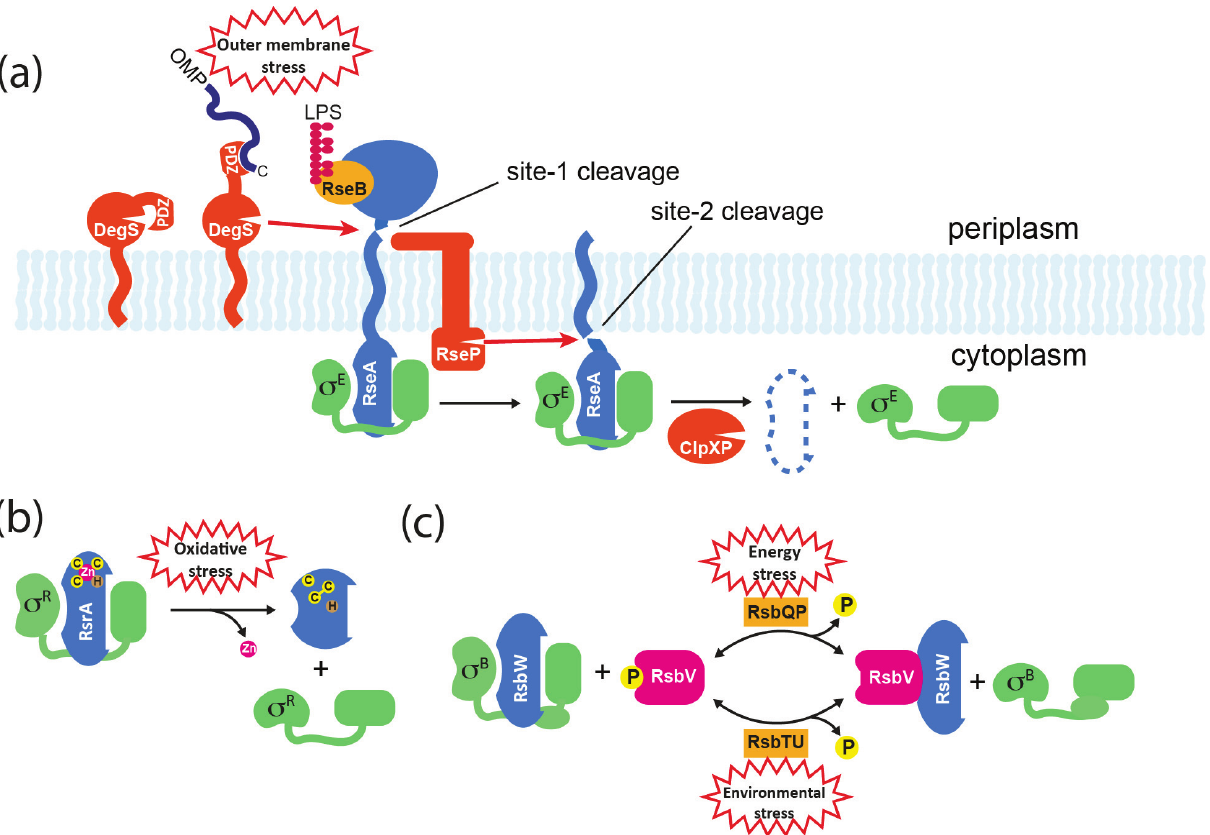
Figure 4. Mechanisms for (cid:2) factor release from anti-(cid:2) factors. ( a ) Activation of (cid:2) E in E. coli . The membrane-spanning anti-(cid:2) RseA binds (cid:2) E through its cytoplasmic ASD. The C-termini of OMPs that accumulate in the periplasm activate DegS protease through binding to its PDZ domain, resulting in site-1 cleavage of RseA. DegS–dependent cleavage of RseA is inhibited by RseB, and this can be relieved by the accumulation of lipopolysaccharide (LPS) in the periplasm that binds directly to RseB. Site-1 cleavage is sensed by RseP, which subsequently catalyzes site-2 cleavage of RseA on the cytoplasmic side of the membrane, releasing a soluble (cid:2) E /RseA complex. (cid:2) E is released when the RseA ASD is finally degraded by ATP-dependent proteases such as ClpXP. ( b ) Activation of (cid:2) R in S. coelicolor. RsrA binds to and inactivates (cid:2) R via its ZASD domain. The RsrA zinc ion is coordinated by three cysteine (C) residues and one histidine (H). In response to oxidative stress, RsrA forms at least one disulphide bond, which concomitantly displaces the zinc and causes a structural change that prevents (cid:2) R binding. The system can be reset by the reduction of RsrA by cellular thiol-disulphide oxidoreductases such as thioredoxin that are activated by (cid:2) R . ( c ) Activation of (cid:2) B in B. subtilis. RsbW is an anti-(cid:2) factor/kinase that binds to (cid:2) B , and additionally inactivates its alternative binding partner RsbV by phosphorylating it to RsbV-P. Activation of (cid:2) B occurs by partner-switching when RsbV-P is dephosphorylated by alternative phosphatases (RsbTU or RsbQP) in response to environmental or energy stresses, which allows RsbV to bind and sequester